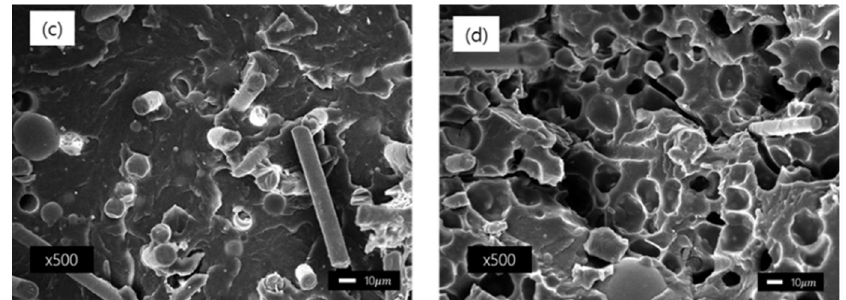
Figure 20. Cross-sectional images of samples taken by a scanning electron microscope: ( a ) unfoamed sample magnified 200 times; ( b ) foamed sample magnified 200 times; ( c ) unfoamed sample magnified 500 times; and ( d ) foamed sample magnified 500 times.